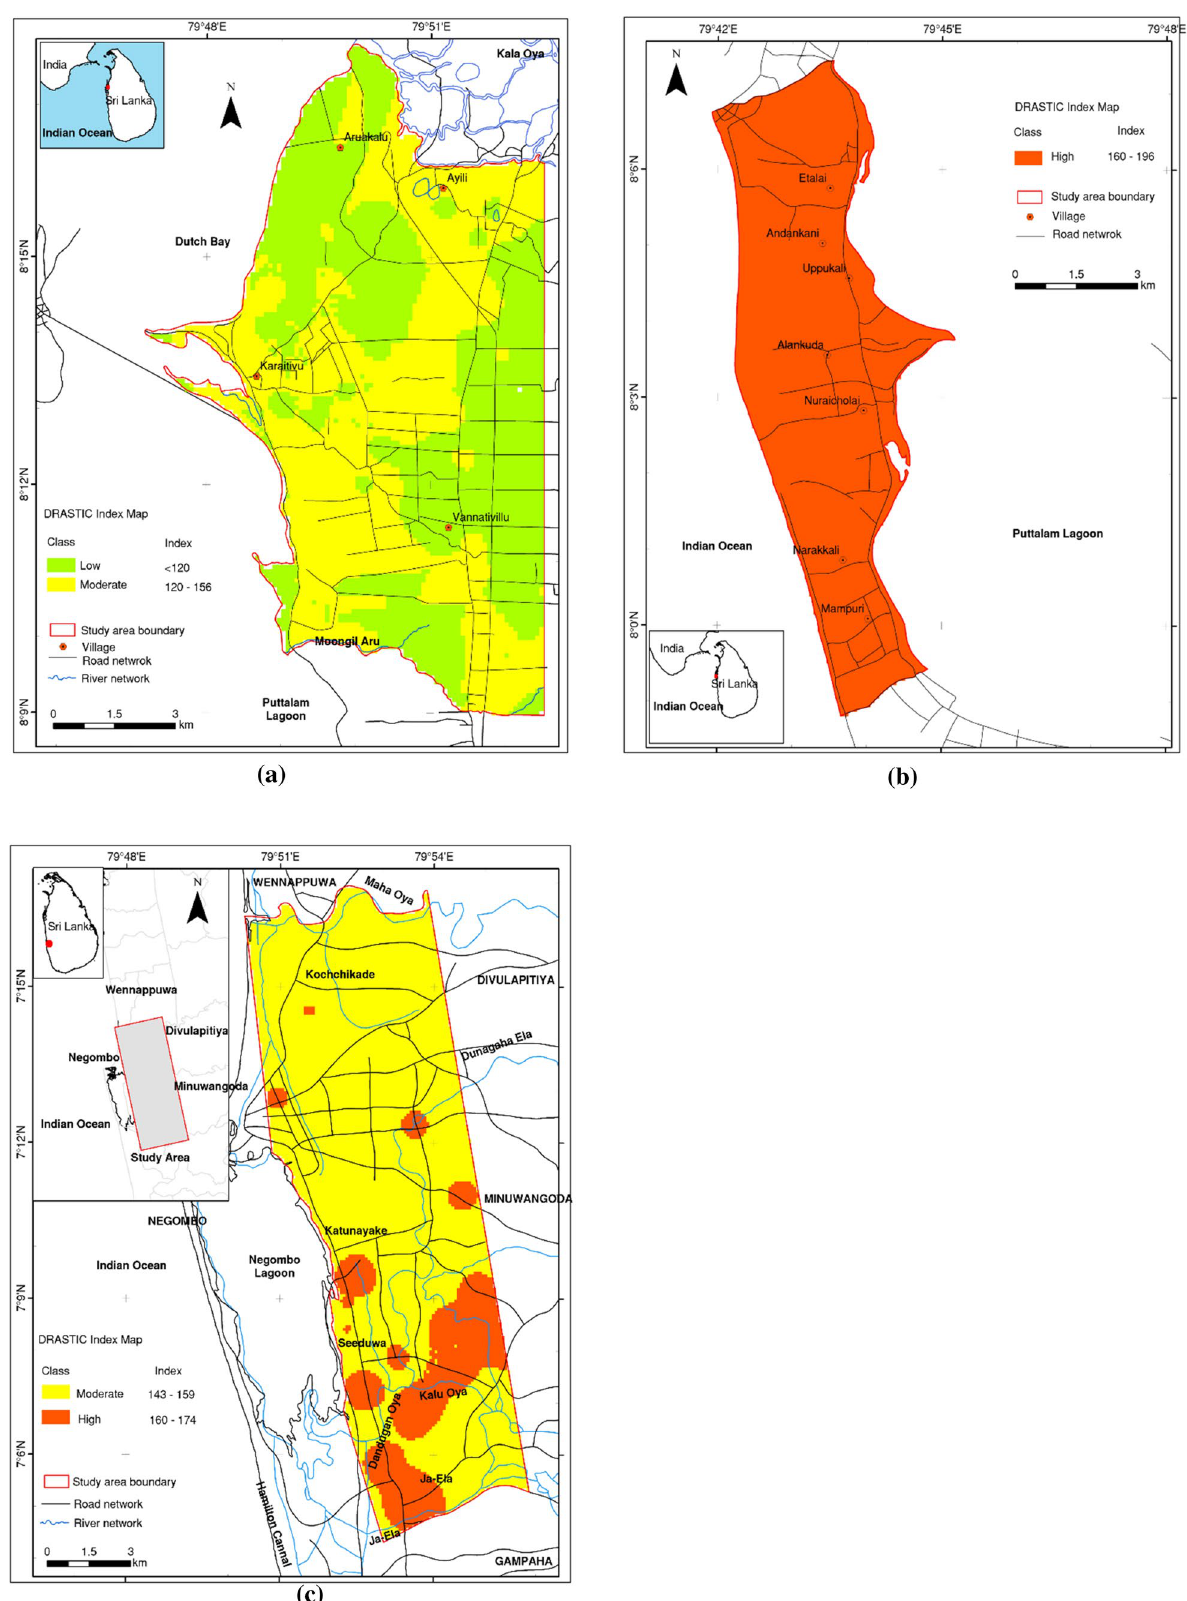
Fig. 3 Intrinsic vulnerability maps of the a Vanathavillu, b Kalpitiya, and c